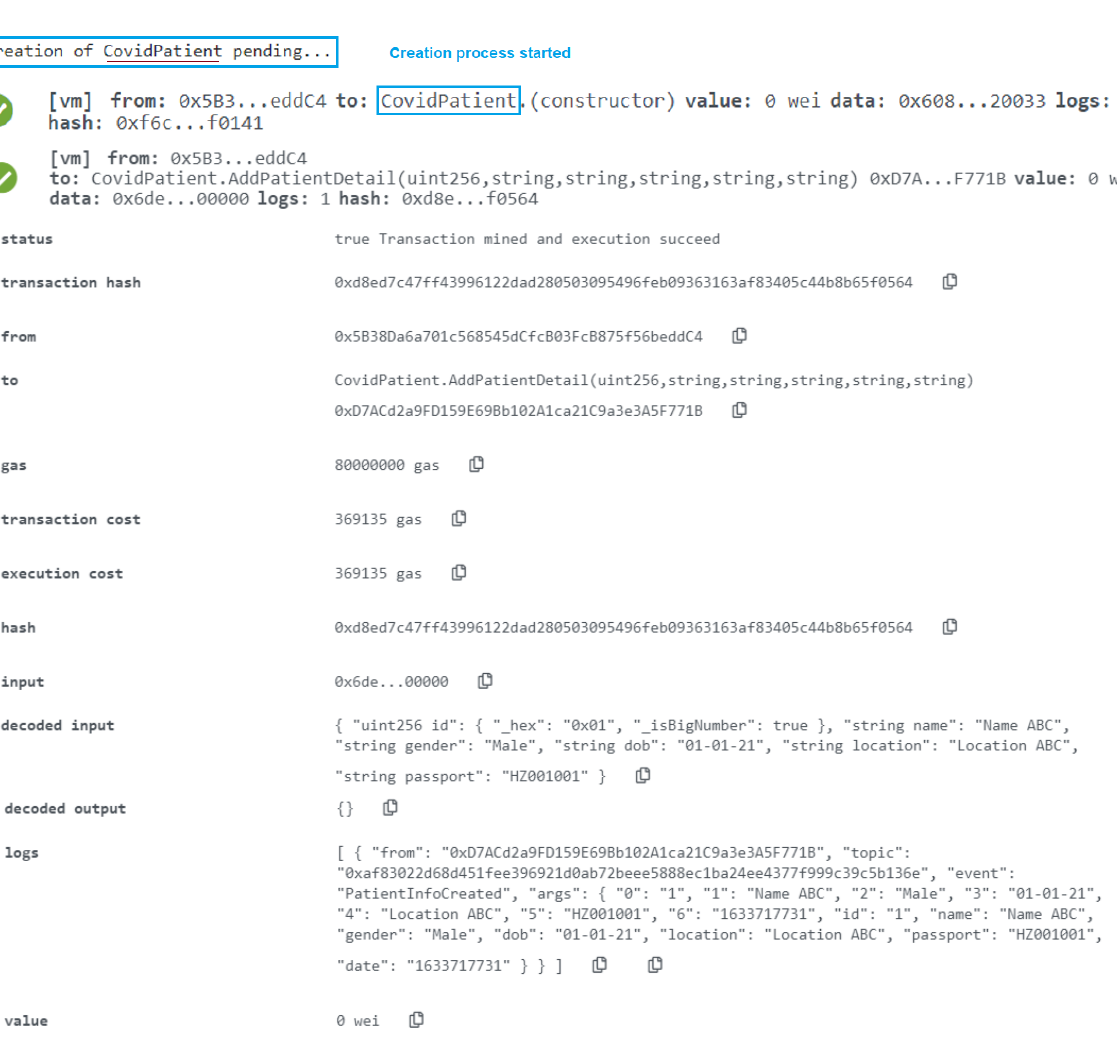
Figure 10. Save COVID ‐ 19 Patient’s detail in the blockchain ledger.